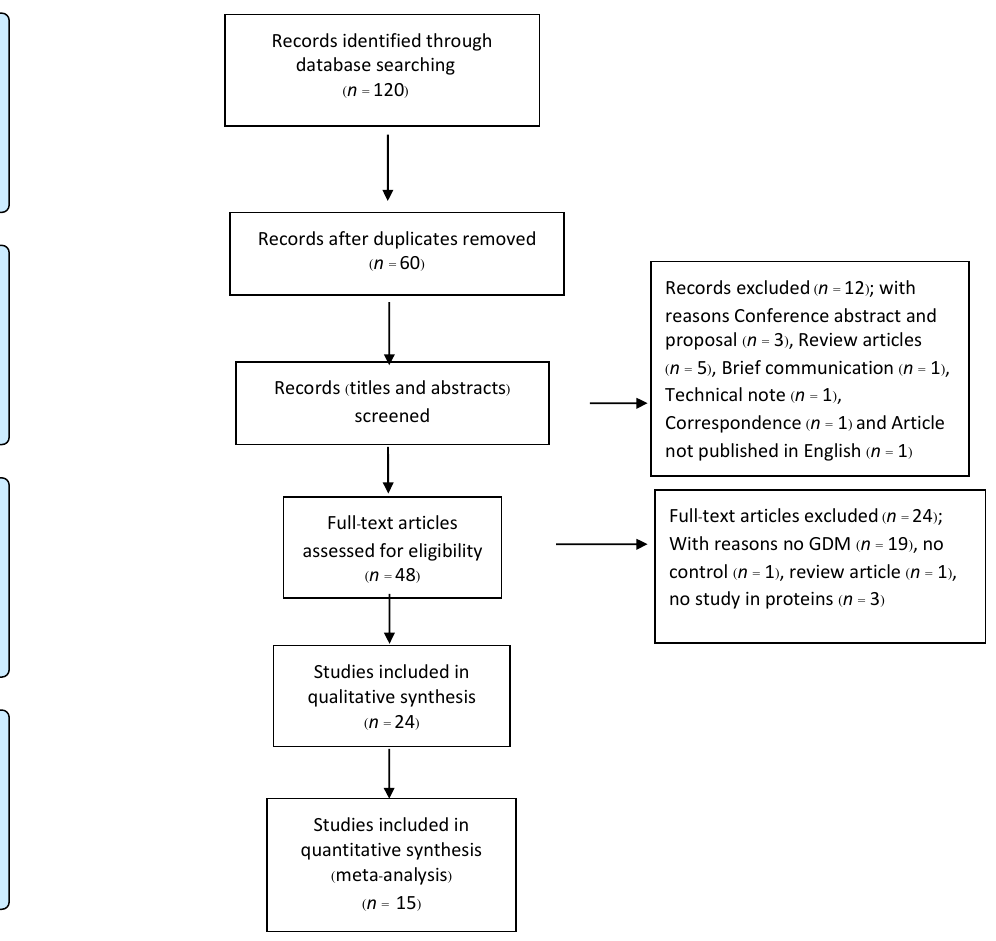
Figure 1. Preferred Reporting Items for Systematic Reviews and Meta-Analyses (PRISMA) chart of study selection for systematic review and meta-analysis.